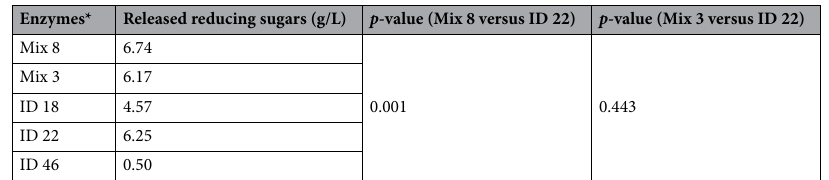
Table 2. Evaluation of additive and synergistic effects between the most active CAZymes (project identification number, ID) on the release of reducing sugars from Laminaria digitata cell wall. *Mix 8: ID 6, 18, 20, 21, 22, 28, 29 and 46; Mix 3: ID 18, 22 and 46.